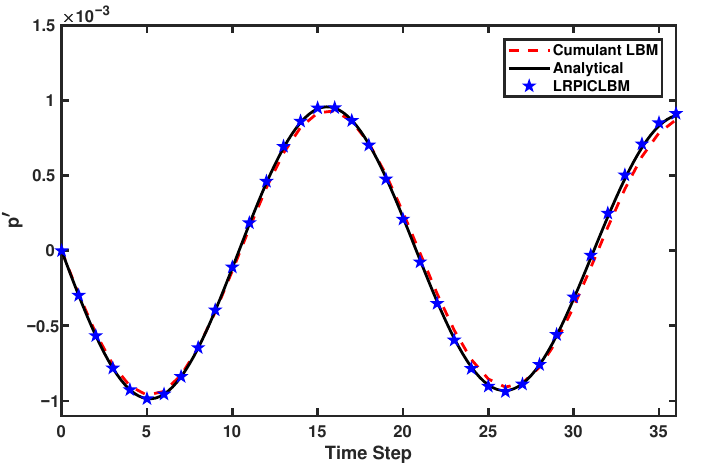
∆ x 2 ∆ t ) with N ppw = 12